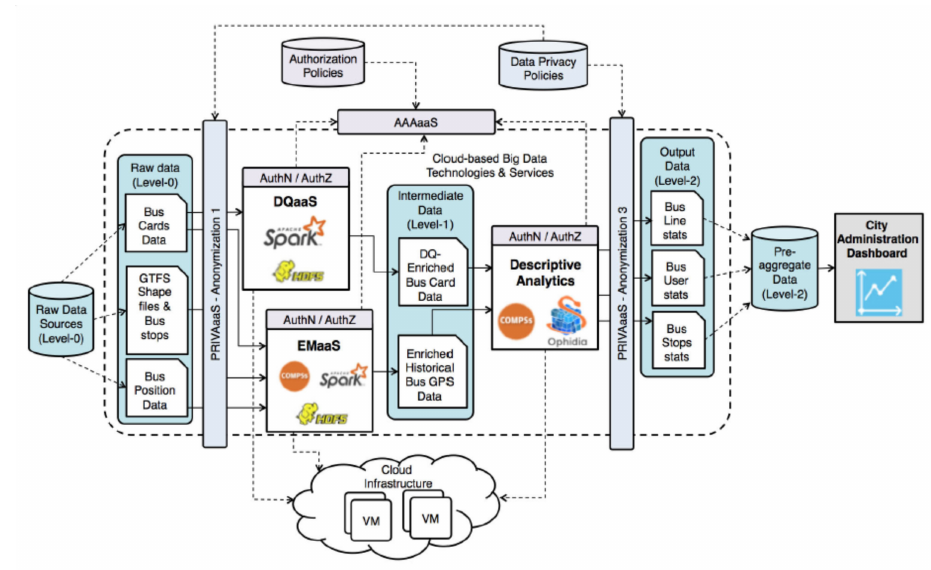
Figure 20. Integrated Big data analytics platform for smart urban transportation